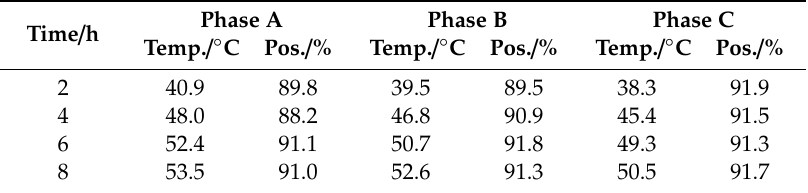
Table 3. The hotspots information of HV winding during the operating time.